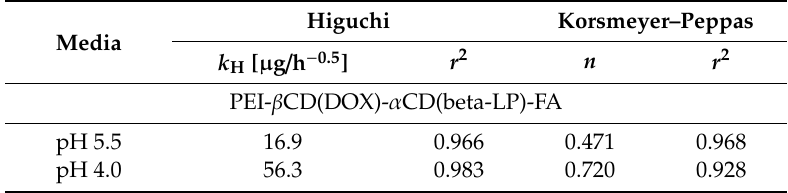
Figure 7. The in vitro release profiles of DOX and beta-Lp from PEI- β CD(DOX)- α CD(beta-LP)-FA nanoconjugate in two media according to Korsmeyer–Peppas ( A ) and Higuchi ( B ) models. Table 1. Change in coefficient ( r ), release rate constant ( k H ), and release exponent ( n ) for studied PEI- β CD(DOX)- α CD(beta-LP)-FA nanoconjugate.